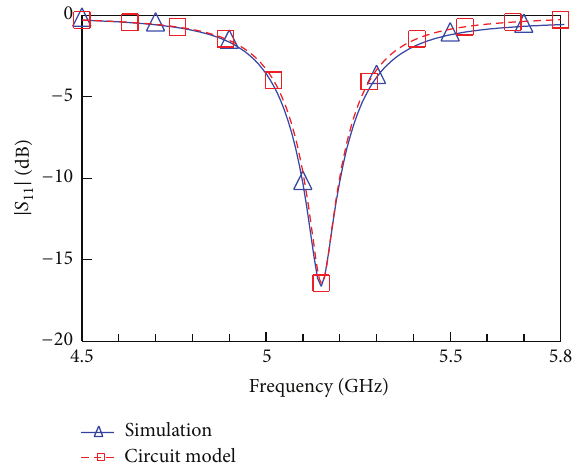
Figure 18: Comparison of circuit model and simulated reflection coefficient results of traditional patch